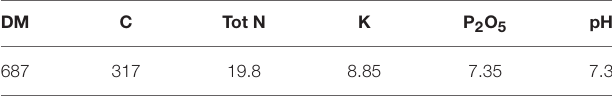
TABLE 2 | Main characteristics of the compost (expressed in g kg − 1